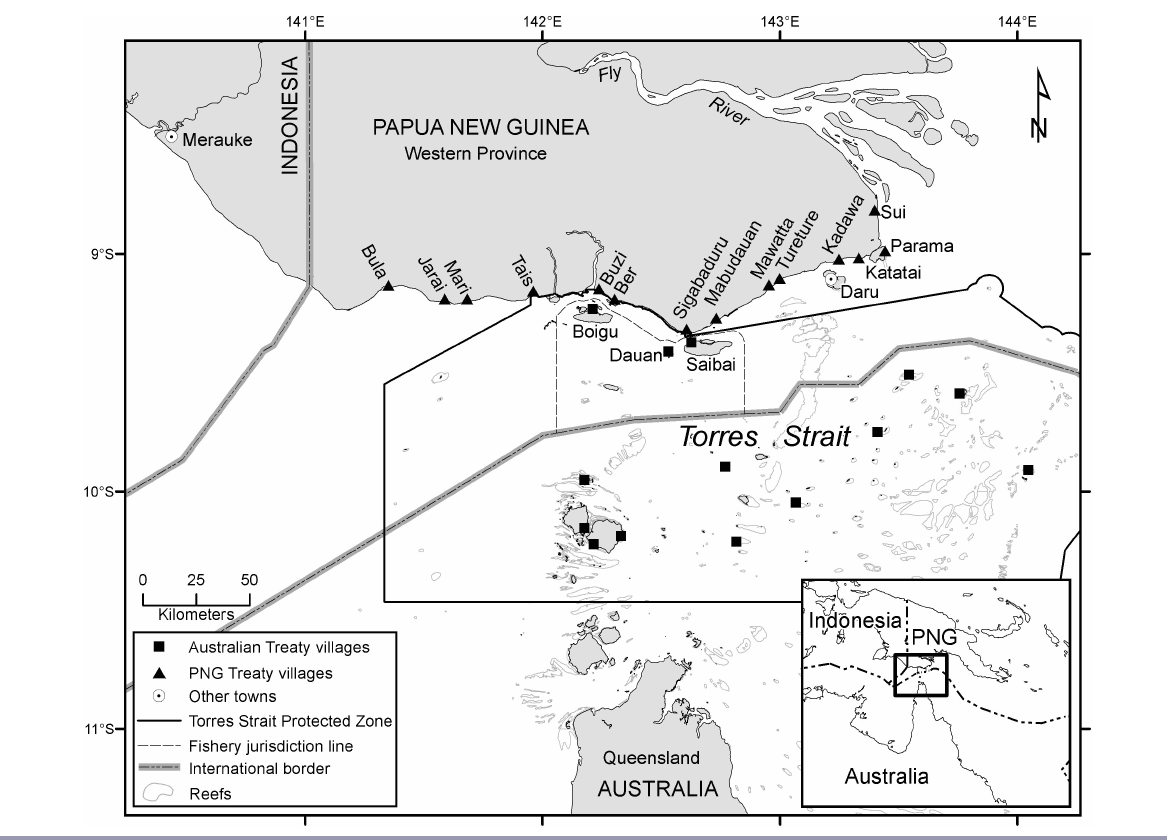
Fig. 1 . The transboundary Torres Strait-Trans-Fly region, showing the 14 Papua New Guinea Treaty Villages and Daru, Merauke, the 14 Australian Torres Strait communities, and the Torres Strait Protected